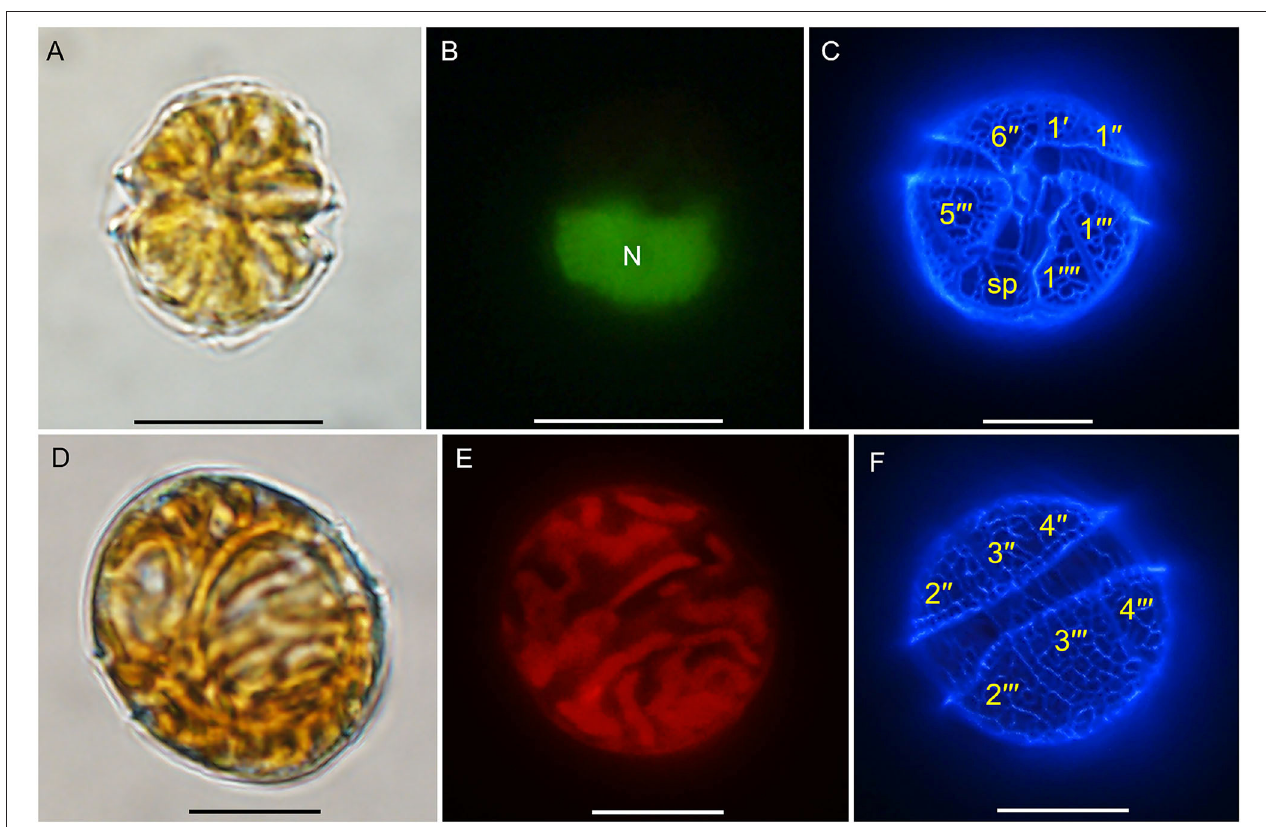
FIGURE 2 | Light microscopy micrographs of Alexandrium insuetum strain AILYG12. (A) Ventral view. (B) SYBR green-stained cell showing the nucleus (N). (C) Ventral view of a calcofluor white-stained cell showing the plate pattern. (D) Dorsal view. (E) Epifluorescence image of vegetative cell showing the chloroplasts. (F) Dorsal view of a calcofluor white-stained cell showing the plate pattern. Scale bars = 10 µ m. sp, posterior sulcal